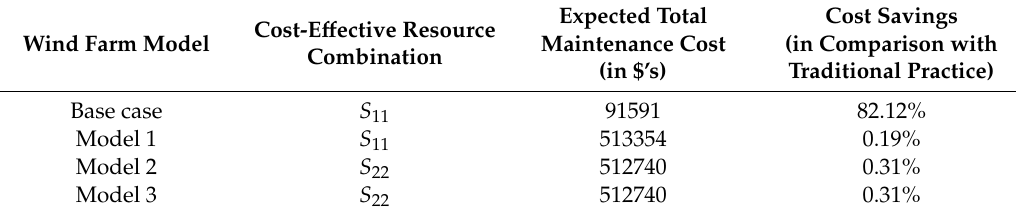
Table 6. Cost-e ff ective resource combination for di ff erent wind farm models given in Table